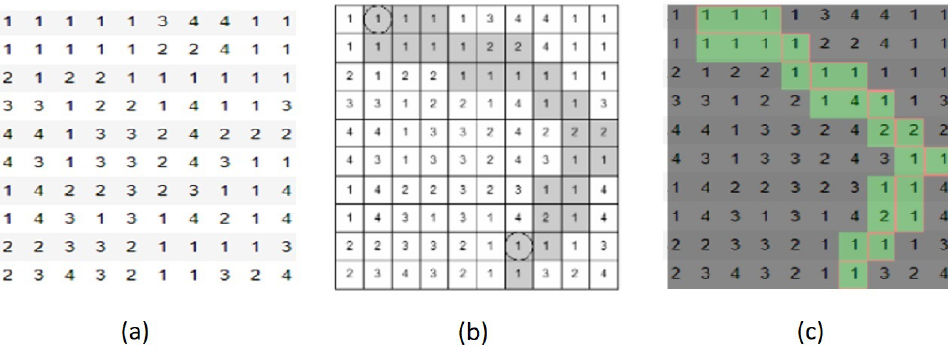
Figure 13. ( a ) The cost raster values in line with [28]. ( b ) The single-mode two-cell-wide LCP found by [28] in grey. ( c ) The single-mode two-cell-wide LCP found by the MLTG method in